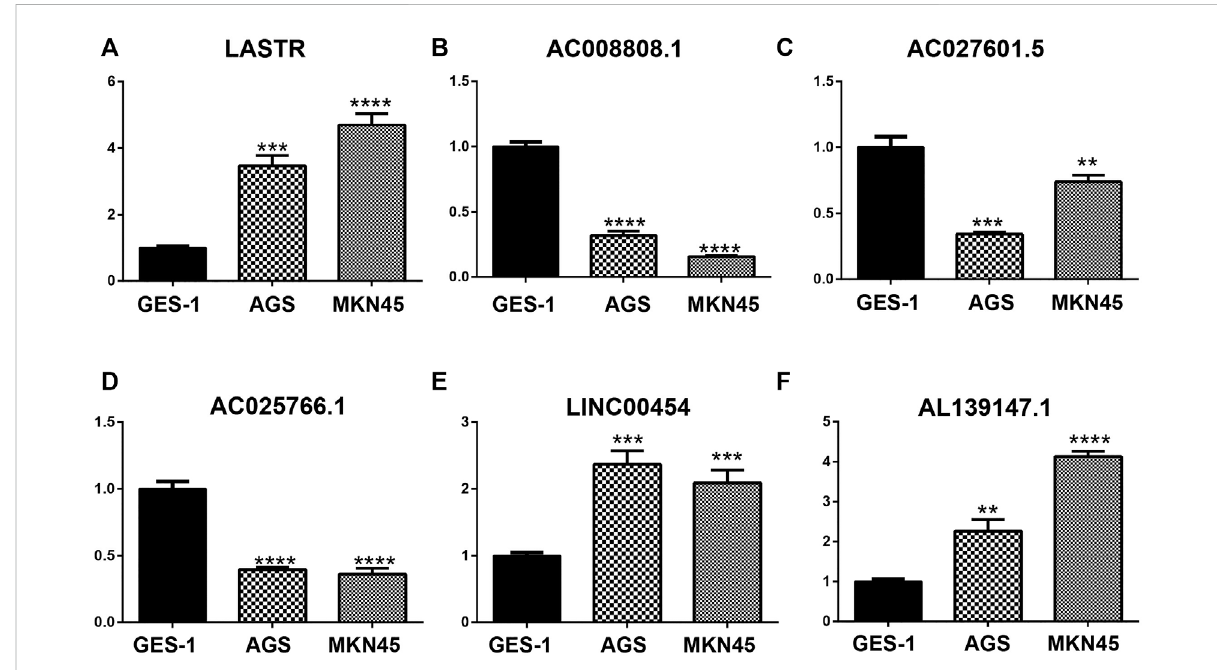
FIGURE 9 The mRNA levels of LASTR, LINC00454, and AL139147.1 were increased in AGS and MKN45 cells, whereas the mRNA levels of AC008808.1, AC027601.5, and AC025766.1 were decreased in AGS and MKN45